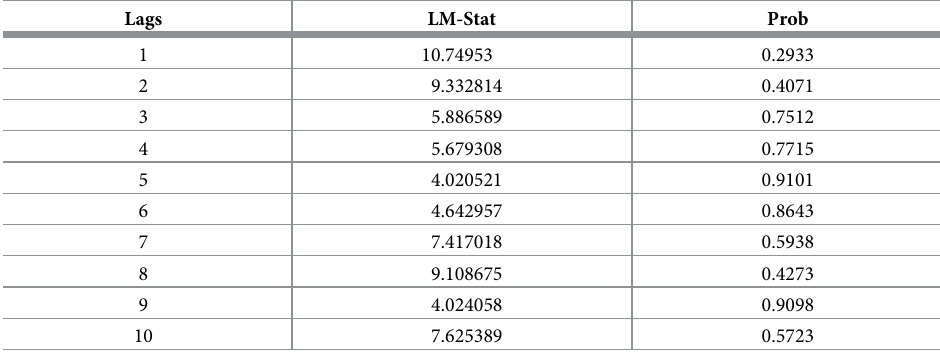
Table 11. Serial correlation LM test for British data when P = 2 (proposed